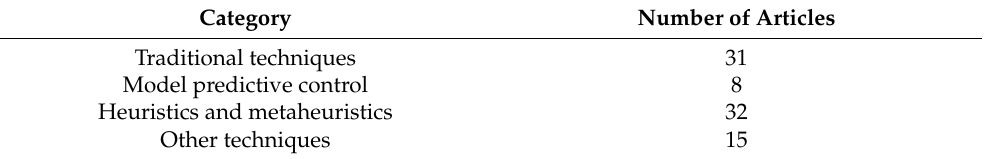
Figure 3. Adopted classification of the HEMS techniques. The number of selected articles according to these categories is shown in Table 4. Table 4. Number of selected articles according to the category of techniques.